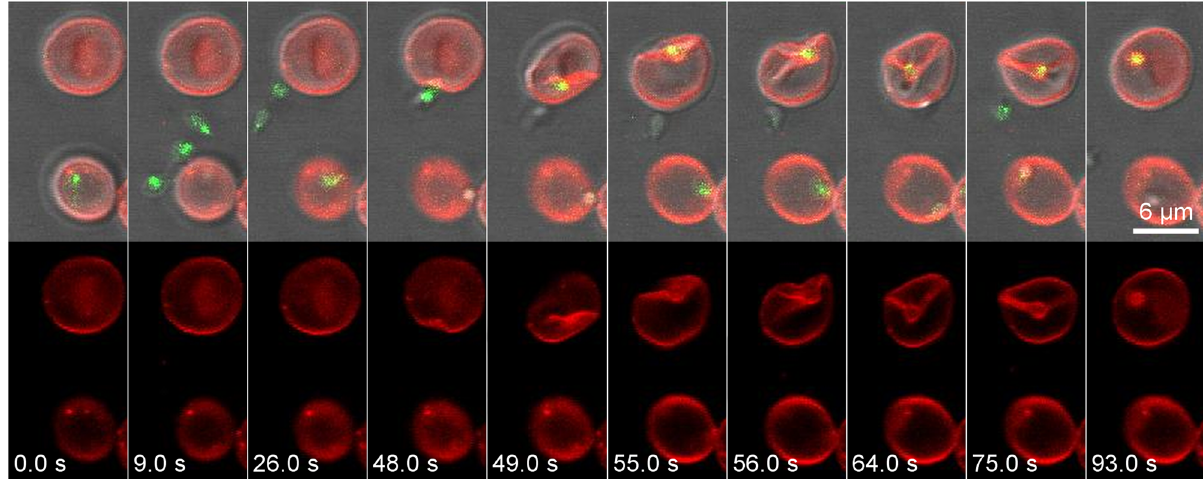
Figure 2. The B. divergens free-merozoite recognizes and invades the human erythrocyte. The panels above show time-lapse image sequences of four B. divergens merozoites stained with MitoTracker (green fluorescent) that are exiting in 9 s from an infected human erythrocyte stained with PKH26 (red fluorescent). One of the merozoites identifies a new erythrocyte and establishes a tight irreversible connection with the erythrocyte plasma membrane causing a deep invagination and deformation to the erythrocyte at 48–75 s. The total internalization of the free merozoite occurs at ≈ 93 s. The parasite is surrounded by the red fluorescent erythrocyte membrane-derived parasitophorous vacuolar membrane after invasion. Simultaneously, the panels below show the PKH26 fluorescence around the infected and non-infected erythrocytes but also around the invasive parasite within the erythrocyte. Time-lapse imaging was captured every 1 s. The time-lapse between each frame is indicated in